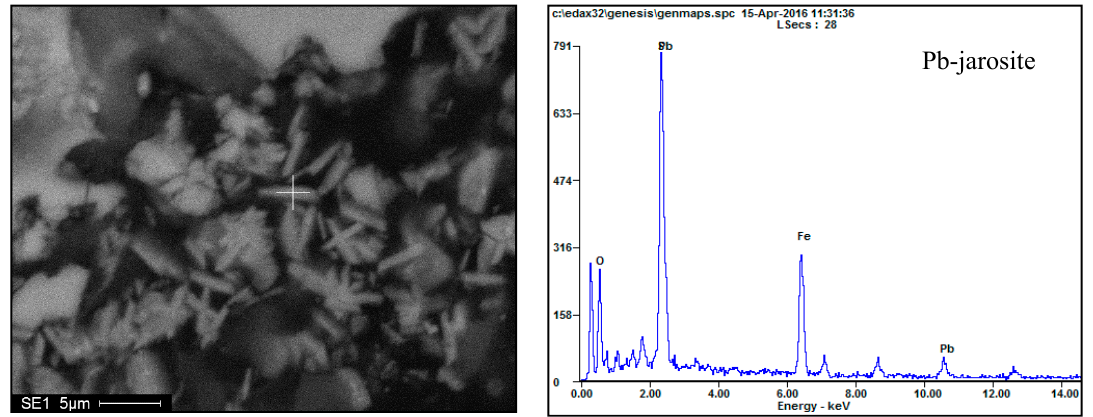
Figure 20. SEM and EDS spectrum for the leach residue obtained at 160 °C.